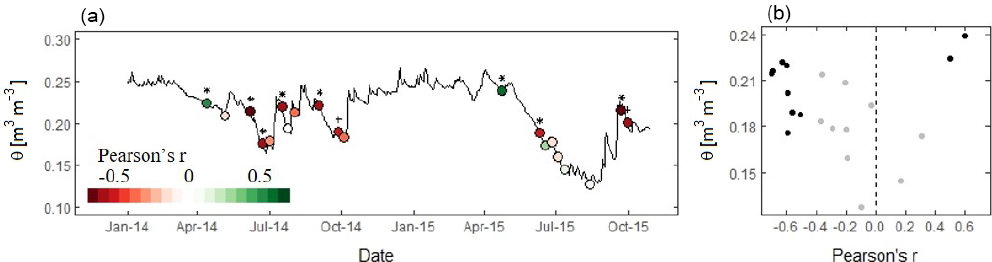
Figure 8. Relationship between sap velocity and NDVI and observed soil moisture content ( θ ). (a) The average soil moisture content at 30cm depth over the sensor clusters. The colours indicate the spatial correlation coefficient (Pearson’s r ) between sap velocity and NDVI for the 20 studied days. Symbols indicate whether the correlation is significant at p < 0 . 05 ( ∗ ) or at p < 0 . 1 ( + ). (b) The soil moisture content and Pearson’s correlation coefficient for the 20 studied days. Black dots indicate that p < 0 . 1. Table 3. Seven (semi-)static sensor cluster characteristics and whether they are significantly correlated ( p < 0 . 05) with spatial variability in mean sap velocity ( α ) and NDVI ( β ). Parentheses indicate a significance level of p < 0 . 1. The results are based on Pearson’s correlation for numerical data and one-way ANOVA for species, geology, and aspect. The mean sensor cluster DBH is the mean DBH of all trees in the sensor cluster, while the mean tree height is the mean of the sap velocity trees only. Species classes are beech, oak, or a mixture. The number of stems, DBH, and tree height are not independent. Mean tree height, aspect, and altitude are related to geology. Italic indicates that the correlation between sap velocity and NDVI was positive for this day, while bold indicates a negative correlation. Year Date Number Mean Mean Species Altitude Geology Aspect of stems